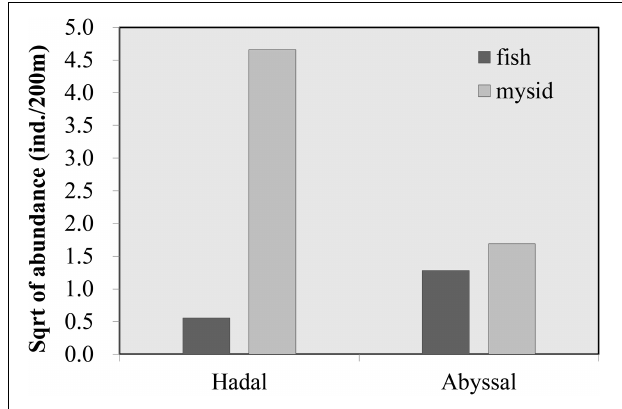
FIGURE 9 | Comparison of the vertical distribution of fish and mysids between the abyssal and hadal zones.